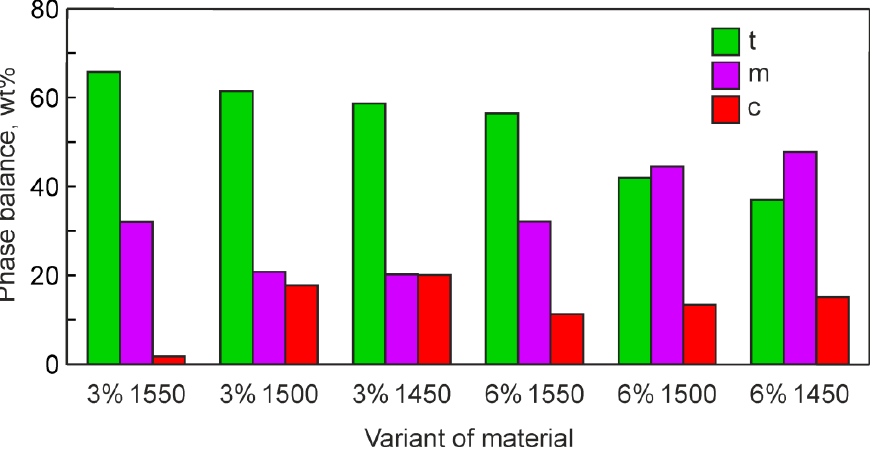
Figure 6. Phase balance for 3YSZ and 6YSZ ceramics sintered at three temperatures. Notation: m is monoclinic, c is cubic, and t is tetragonal ZrO 2 .